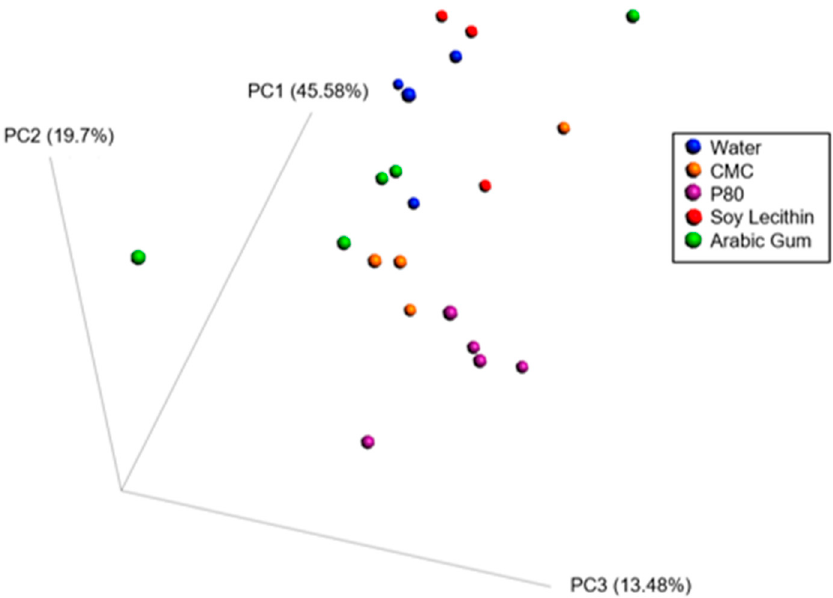
Figure 3. Principle coordinate analysis of the Bray–Curtis distance using a matrix containing morphometric parameters (final body weight percentage, adipose weight, colon weight, colon length, caecum weight, fasting blood glucose level, food intake).